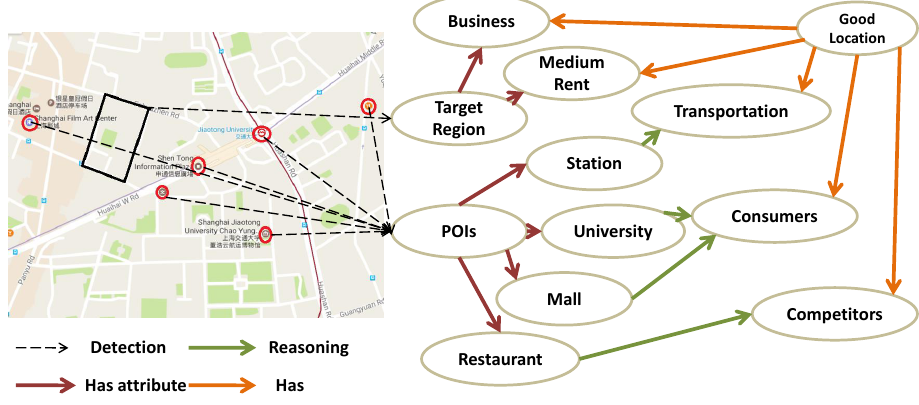
Figure 1. Example of how semantic knowledge of region aids store